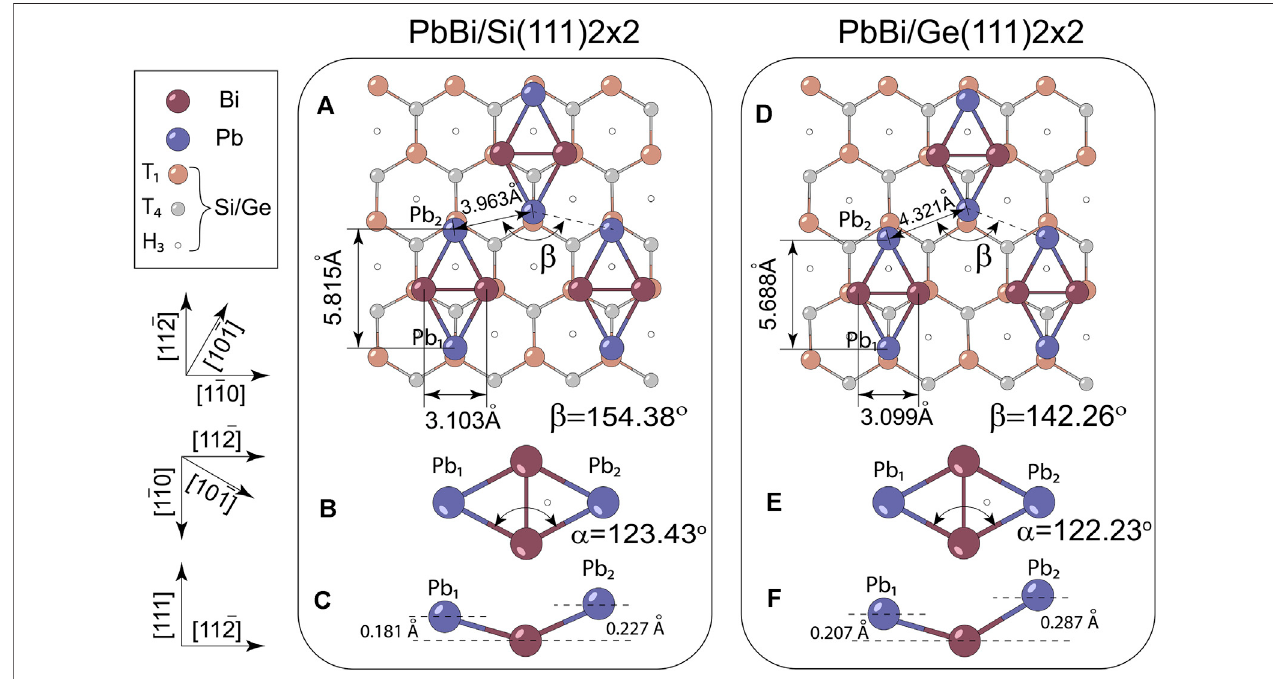
FIGURE5| Thedetailsof2×2-Pb,Biatomicstructureadsorbedon (A – C) Si(111),and (D,E,F) Ge(111)substratesintopandthesideviewswithindicationofbond lengths, heights and angles of the rhombi itself ( α ) and zig-zag Pb chain ( β ).